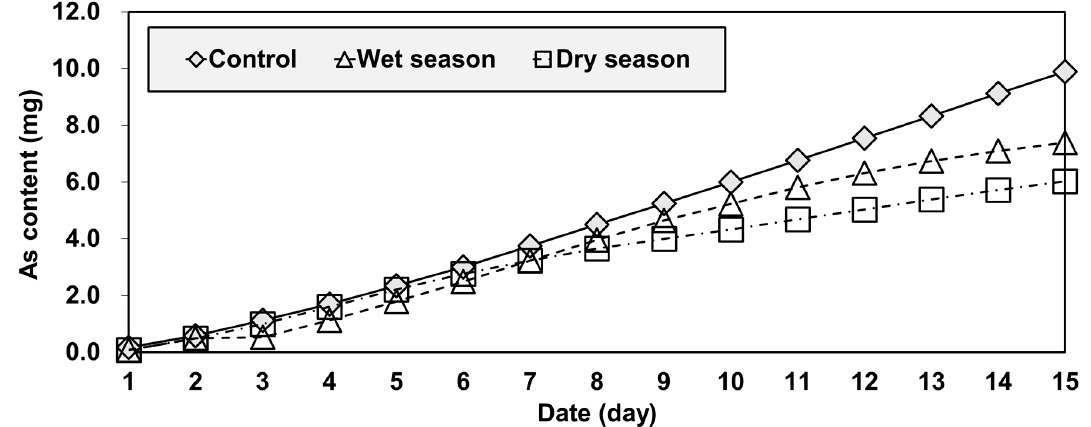
Figure 8. Comparison of the cumulative amount of arsenic leached from the three samples.